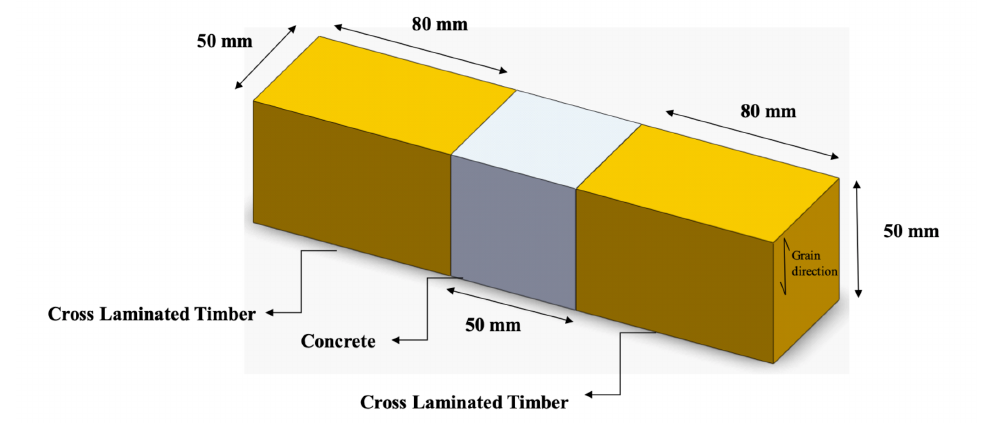
Figure 2. Double lap joint geometry.